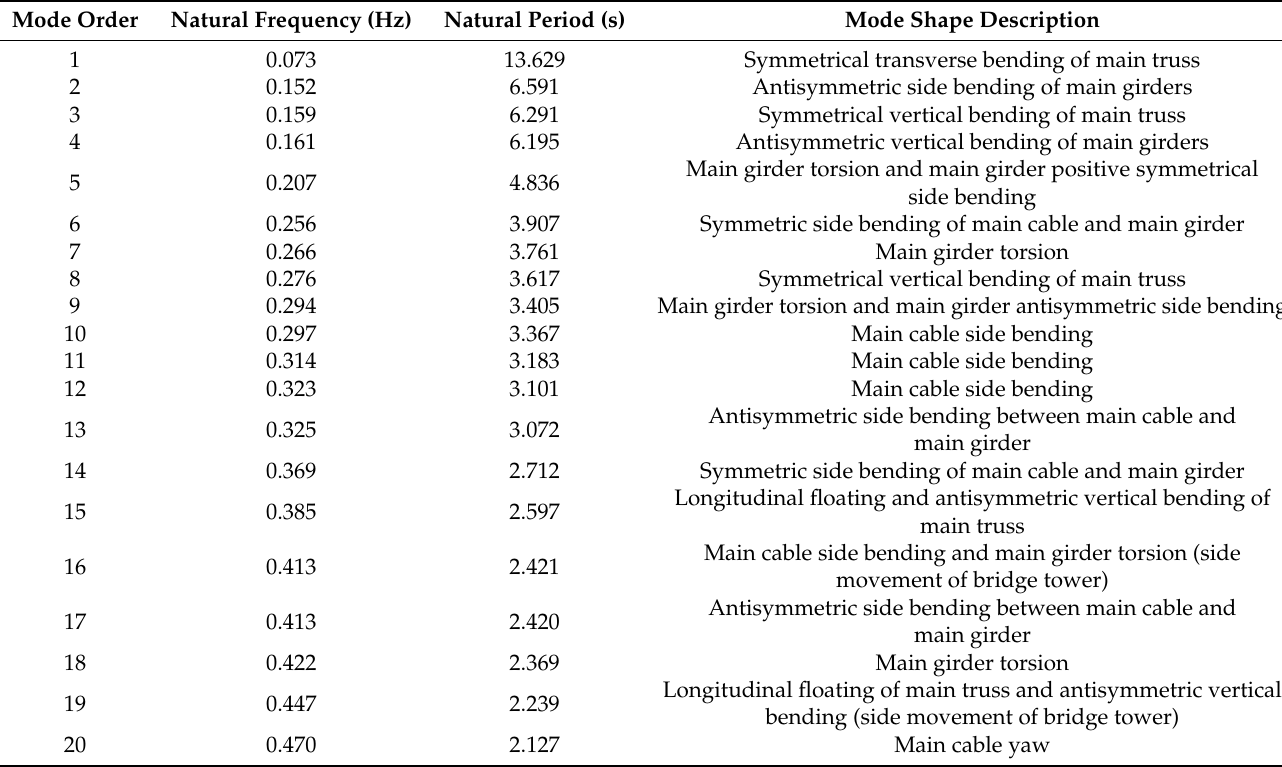
Table 3. Natural frequency of the